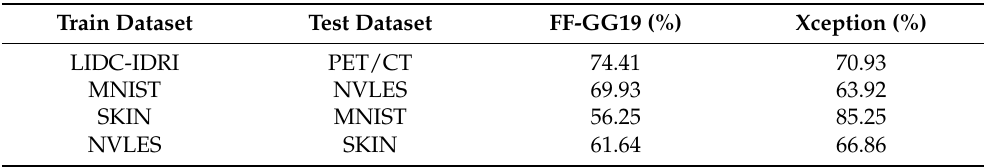
Table 9. FF-VGG19 and Xception network performance under medical image acquisition device variation.